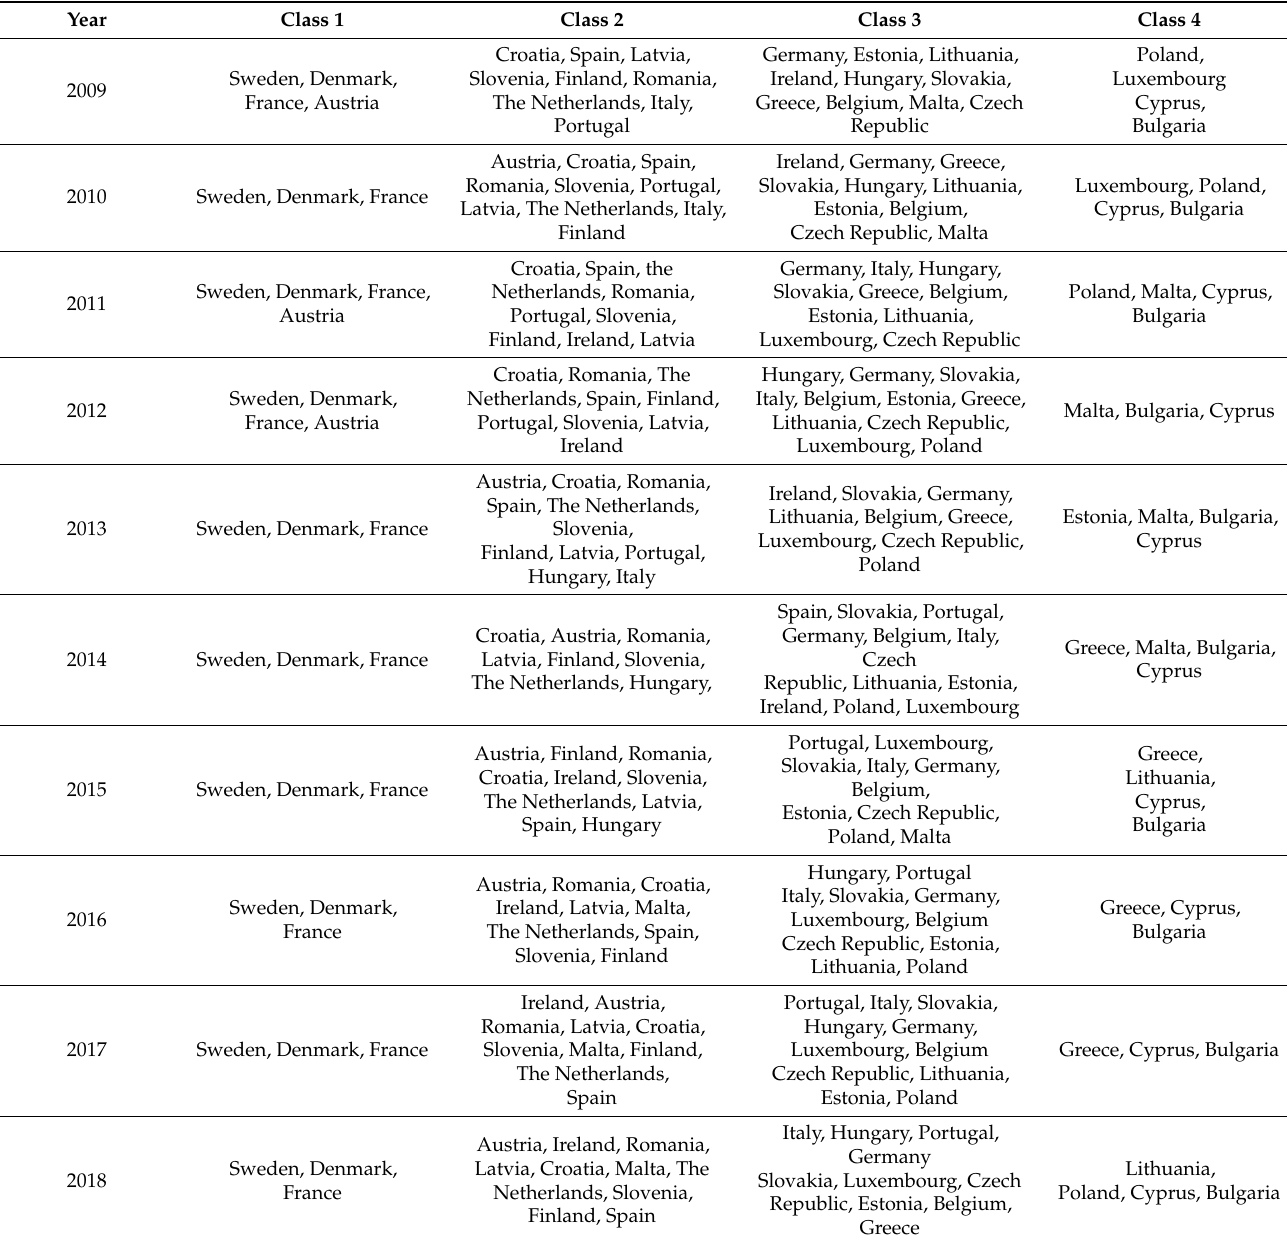
Table 3. The groups of similar countries in terms of energy and climate sustainable